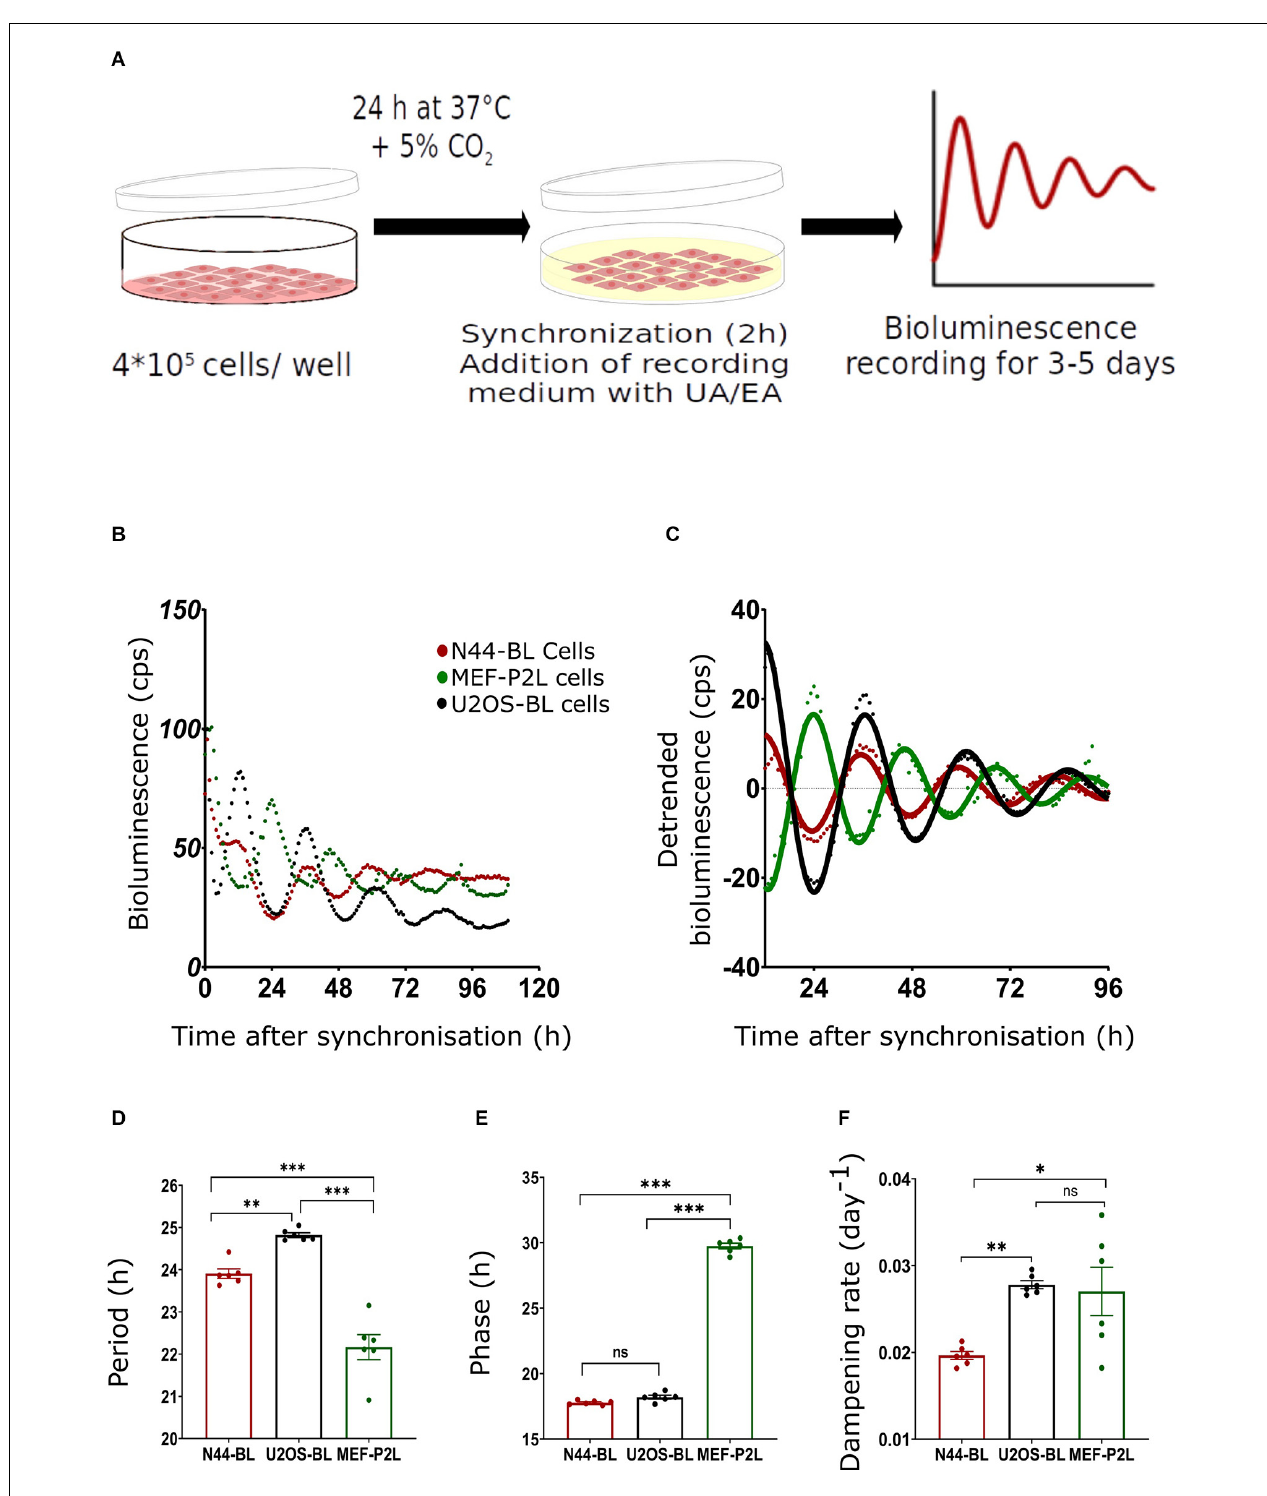
FIGURE 1 | Characterization of circadian luminescence rhythms in N44, U2OS, and MEF cells. (A) Experimental setup; for more details, see text. (B) Representative raw and (C) representative normalized data and sine curve fittings of Bmal1:luc (BL) and Per2:luc (P2L) luminescence recordings of hypothalamus-derived mouse N44 (N44-BL), human bone osteosarcoma epithelial (U2OS-BL), and mouse embryonic fibroblast (MEF-P2L) cells after synchronization with dexamethasone (Dex). (D–F) Luminescence period lengths (D) , rhythm phases (E) , and dampening rates (F) of the same data set. Single measures are shown; error bars indicate means ± SEM ( ∗ p < 0.05, ∗∗ p < 0.01, ∗∗∗ p < 0.001; 1-way ANOVA with Dunnett’s post- test; n = 6). ns, non-significant.